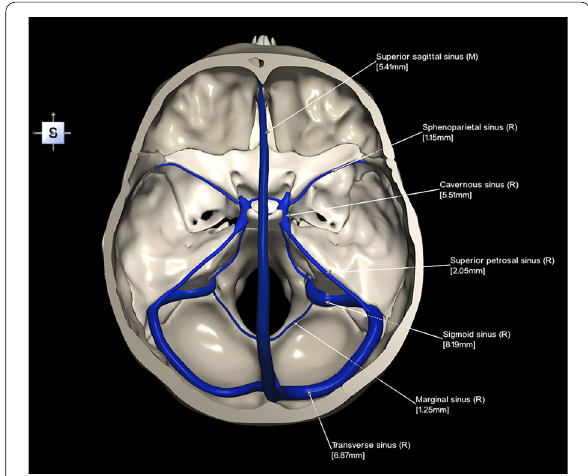
Fig. 5 Skull base with the dural sinuses labeled (note that the vessels are also labeled with their diameters)